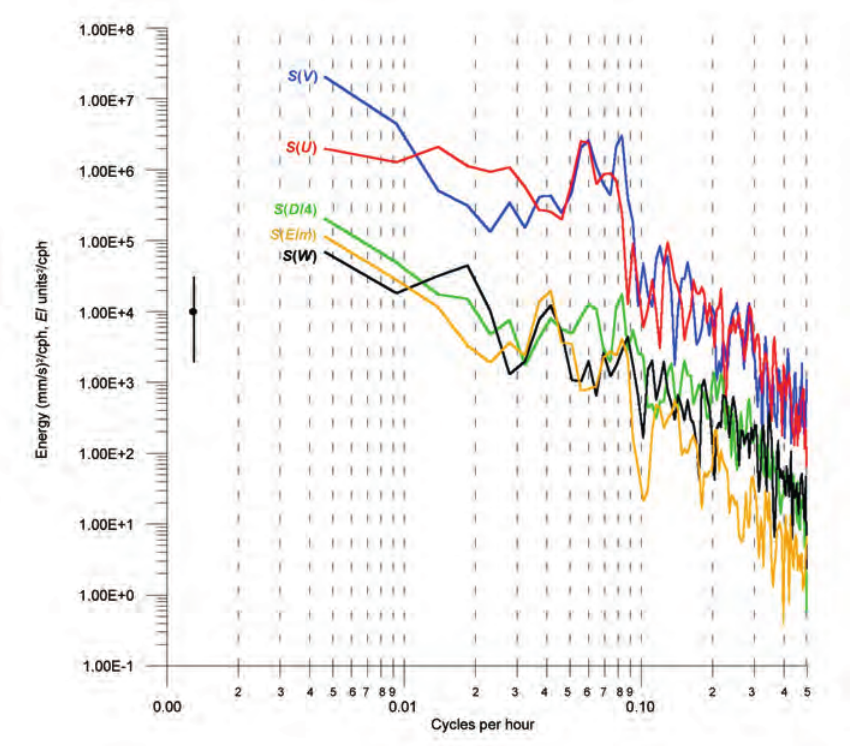
Fig. 10. Spectra of U (red), V (blue), W (black), EIm (orange) and DI 4 (green) at cell #5 averaged over 2 pieces to give 4° of freedom. The confidence interval is the 90%